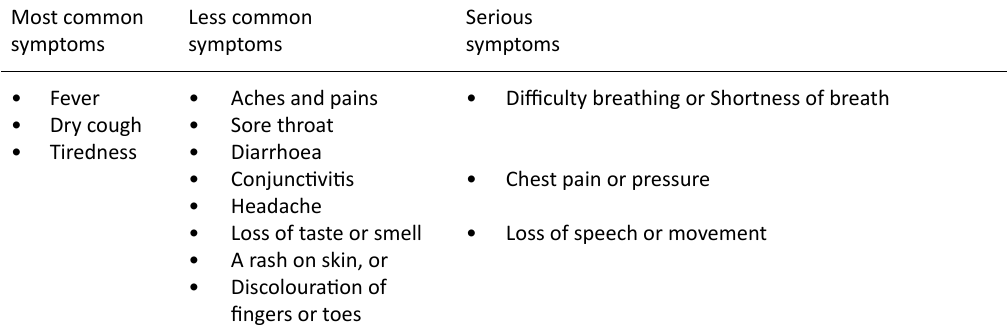
table 1. Symptoms of COVID-19. Data adapted from World Health Organization Most common